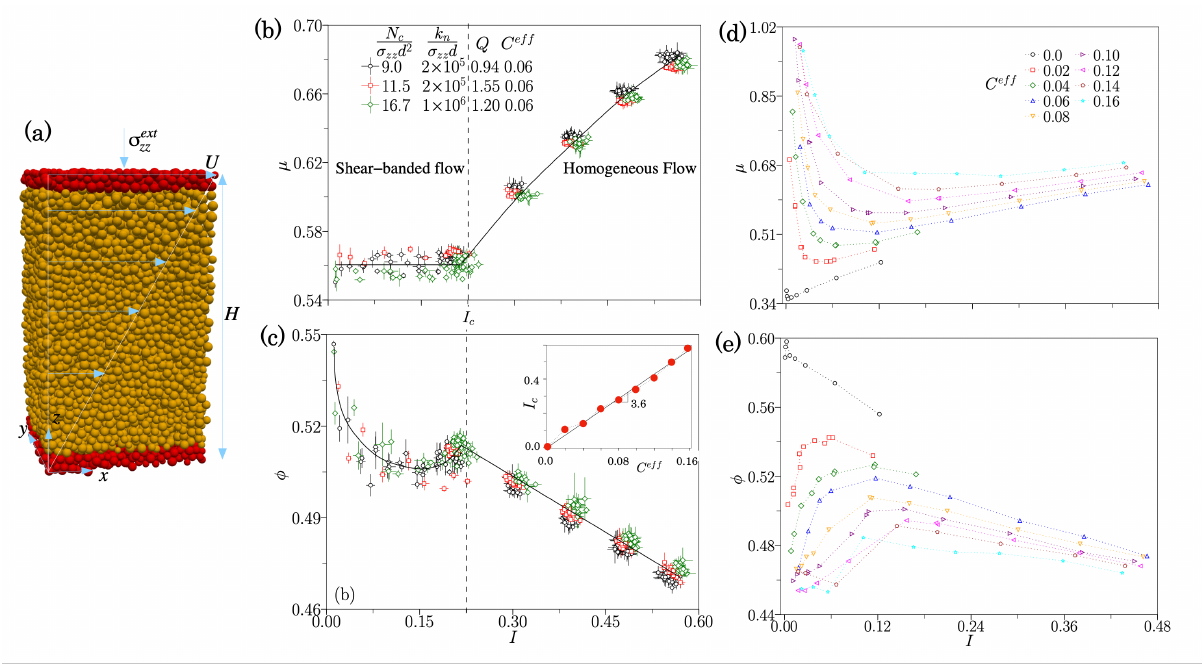
Figure 3. Plane shear cell: (a) sketch of the simulated configuration; (b) friction coe ffi cient and (c) volume fraction as function of the inertial number I for various particle parameters keeping the "e ff ective" cohesion number the same C ef f = 0 . 06, for a large system H = 34 d . Inset: I c delimiting the occurence of shear banding as a function of C ef f . (d) friction coe ffi cient µ and (e) volume fraction φ as a function of I in a small system H = 8 d for which the flow remains uniform, for di ff erent cohesion number C ef f .